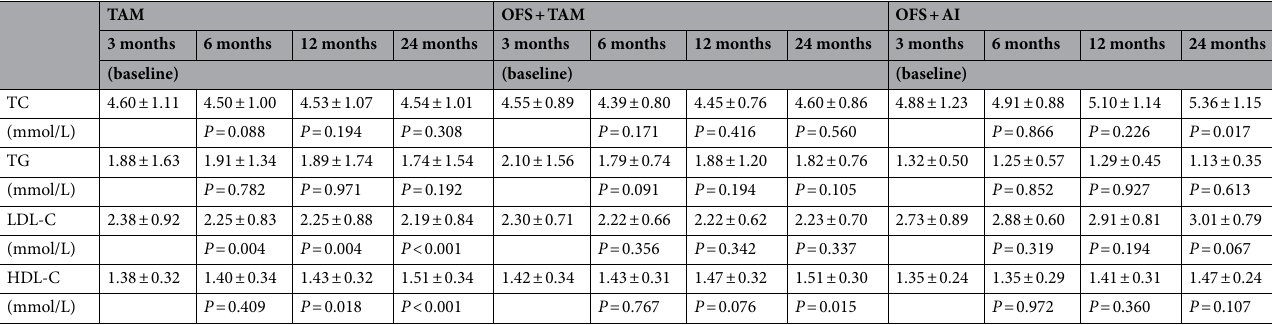
(Fig. 2). Different groups revealed an opposite trend (Fig. 3). LDL-C levels remained stable at all time points in OFS plus TAM group.